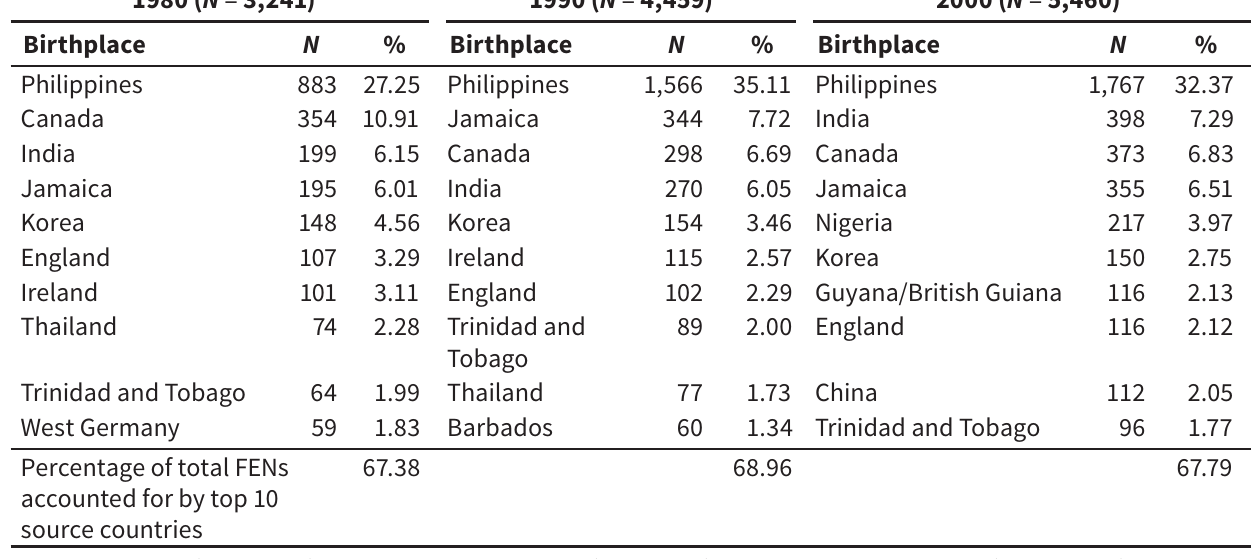
Table 2 Top 10 source countries for employed FENs in the United States, 1980–2015 1980 ( N = 3,241) 1990 ( N = 4,459)